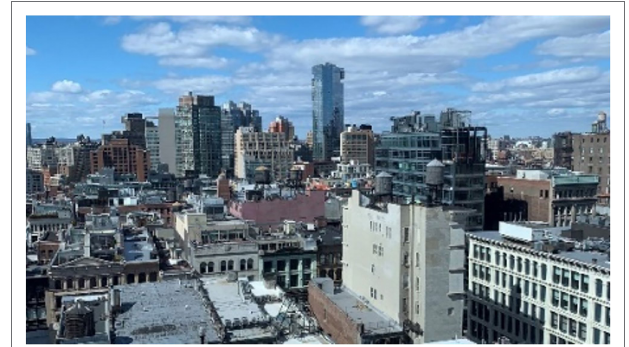
FIGURE 3 | The urban image shown for 40 s between the baseline and post-intervention SARTs in Study